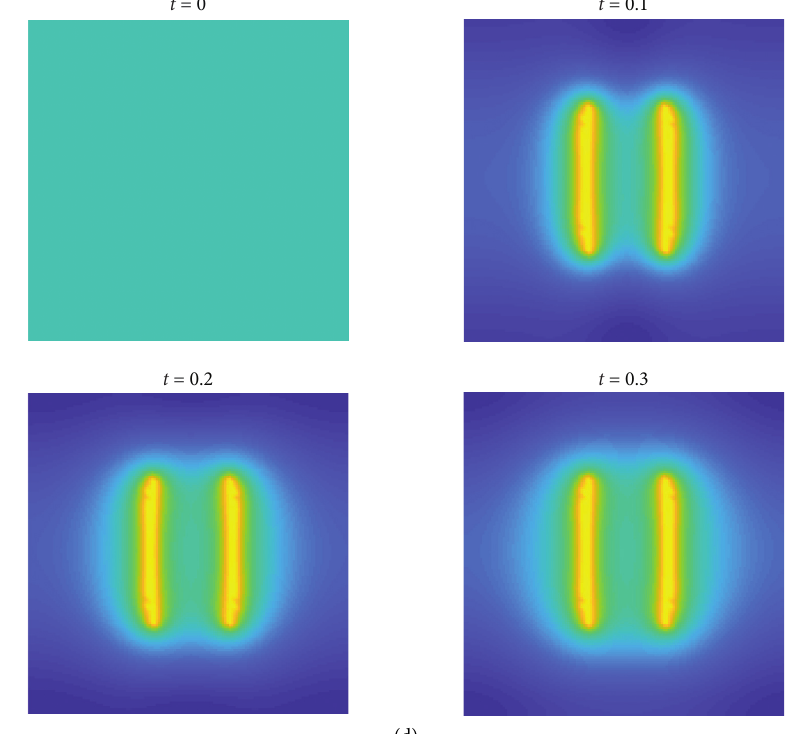
Figure 16: Numerical solution and Turing pattern of Experiment 2 with initial condition u ( x,y, 0 ) � ( 12/25 ) − sin ( 10 x 2 − 510 )+ sin ( cos ( y − 22 )) and v ( x,y, 0 ) �